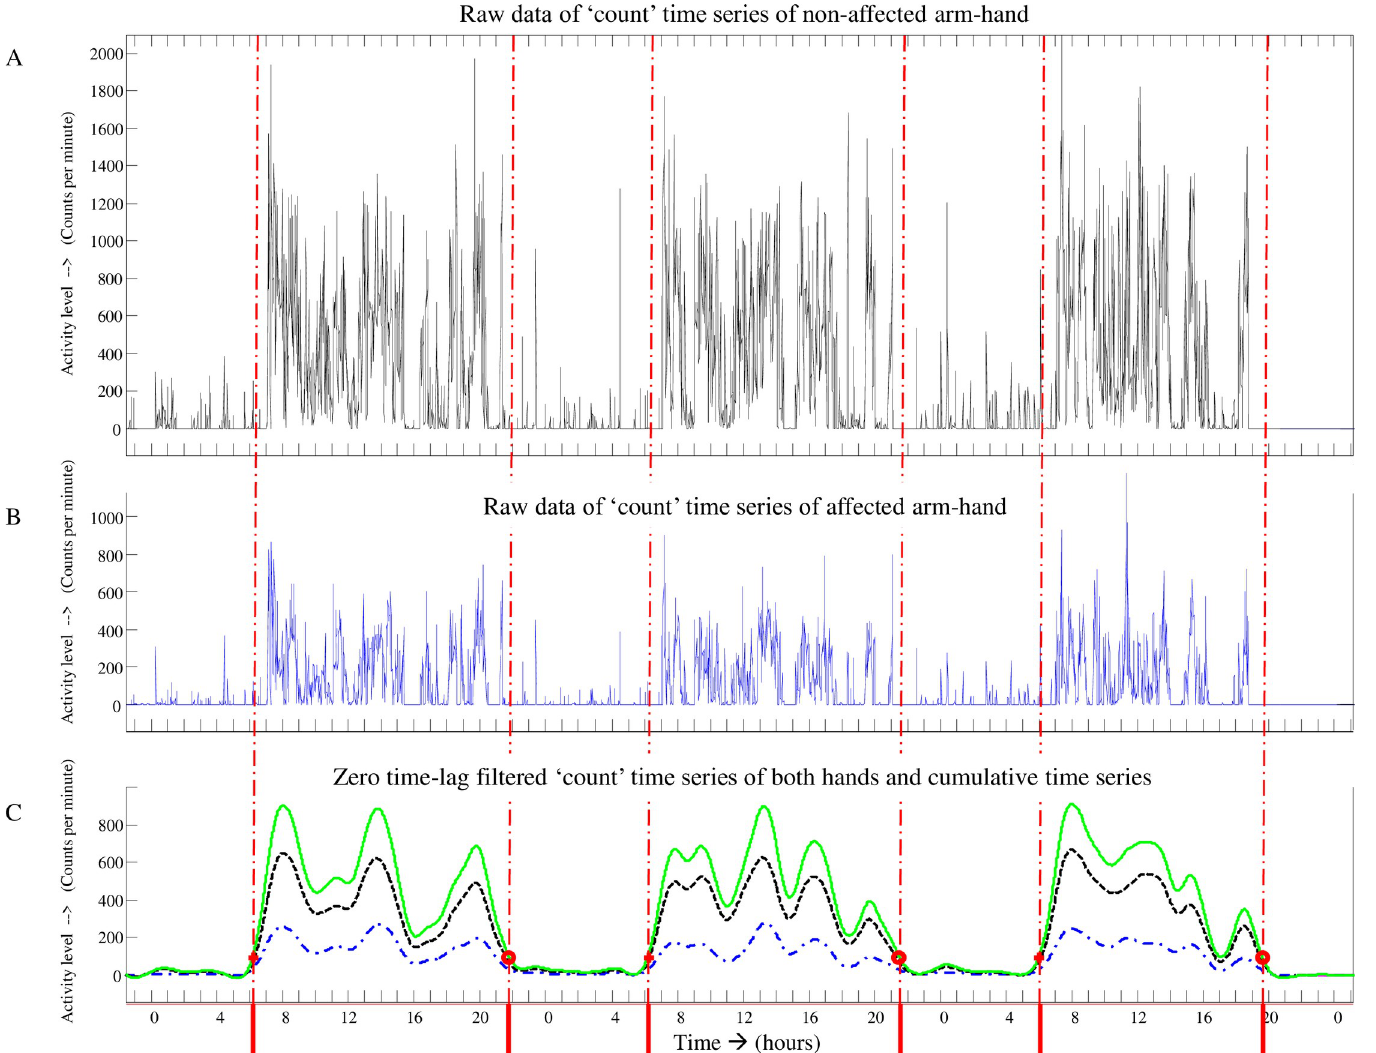
Fig 2. Accelerometer data ‘count’ time series of three consecutive days. A = ‘count’ time series from the non-affected arm; B = count’ time series from the affected arm; Dotted time series in Fig 2C = zero time-lag filtered signal from non-affected arm; Dashed-dotted time series in Fig 2C = zero time-lag filtered signal from affected arm; Solid time series in Fig 2C = cumulative signal representing both filtered signals; vertical dashed-dotted lines = start and end of the so-called ‘uptime’ per day.